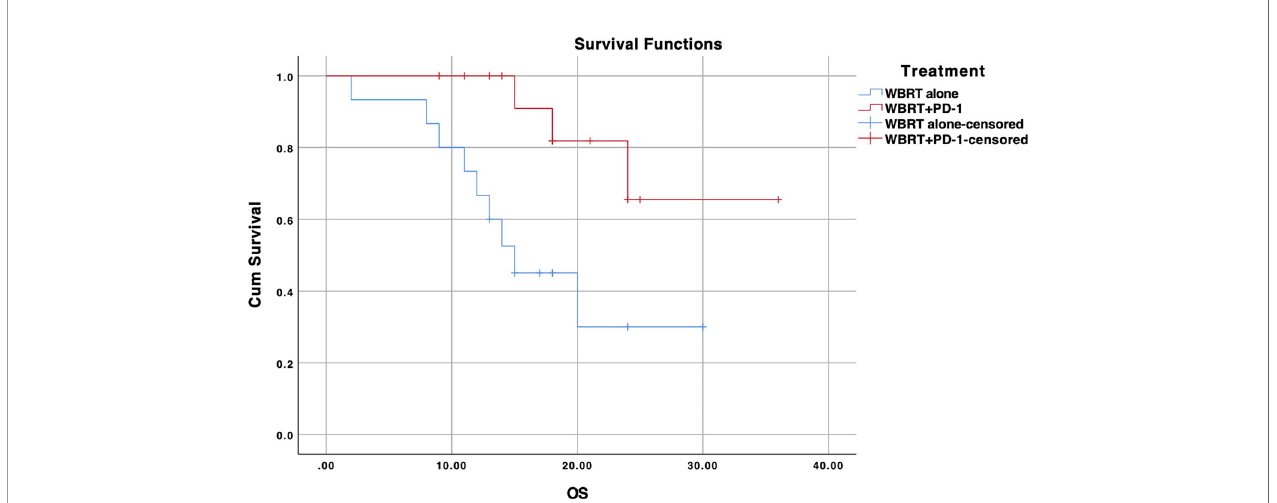
FIGURE 4 | Kaplan-Meier progression-free survival (PFS) curve for treatments in EGFR wildtype NSCLC subgroup; WBRT alone (No PD-1), and WBRT plus PD-1 inhibition therapy (WBRT+PD-1). Cum, cumulative.